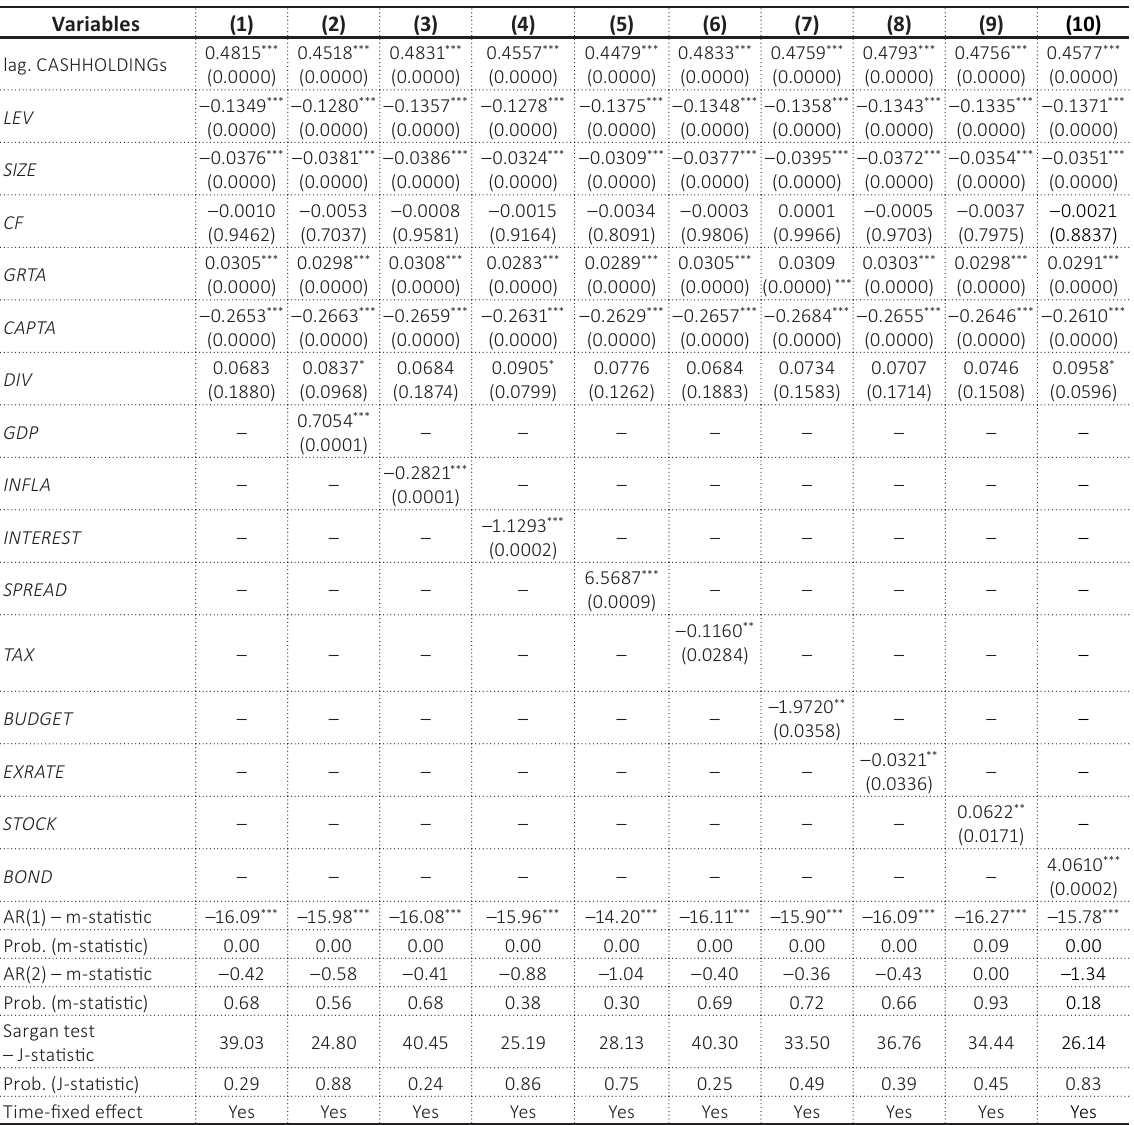
Table 6. Influence of debts and macroeconomic factors on corporate cash holdings in a dynamic